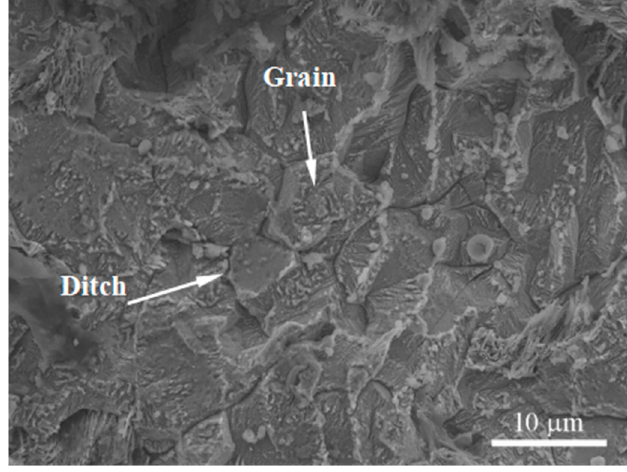
Figure 9. The inter-crystalline